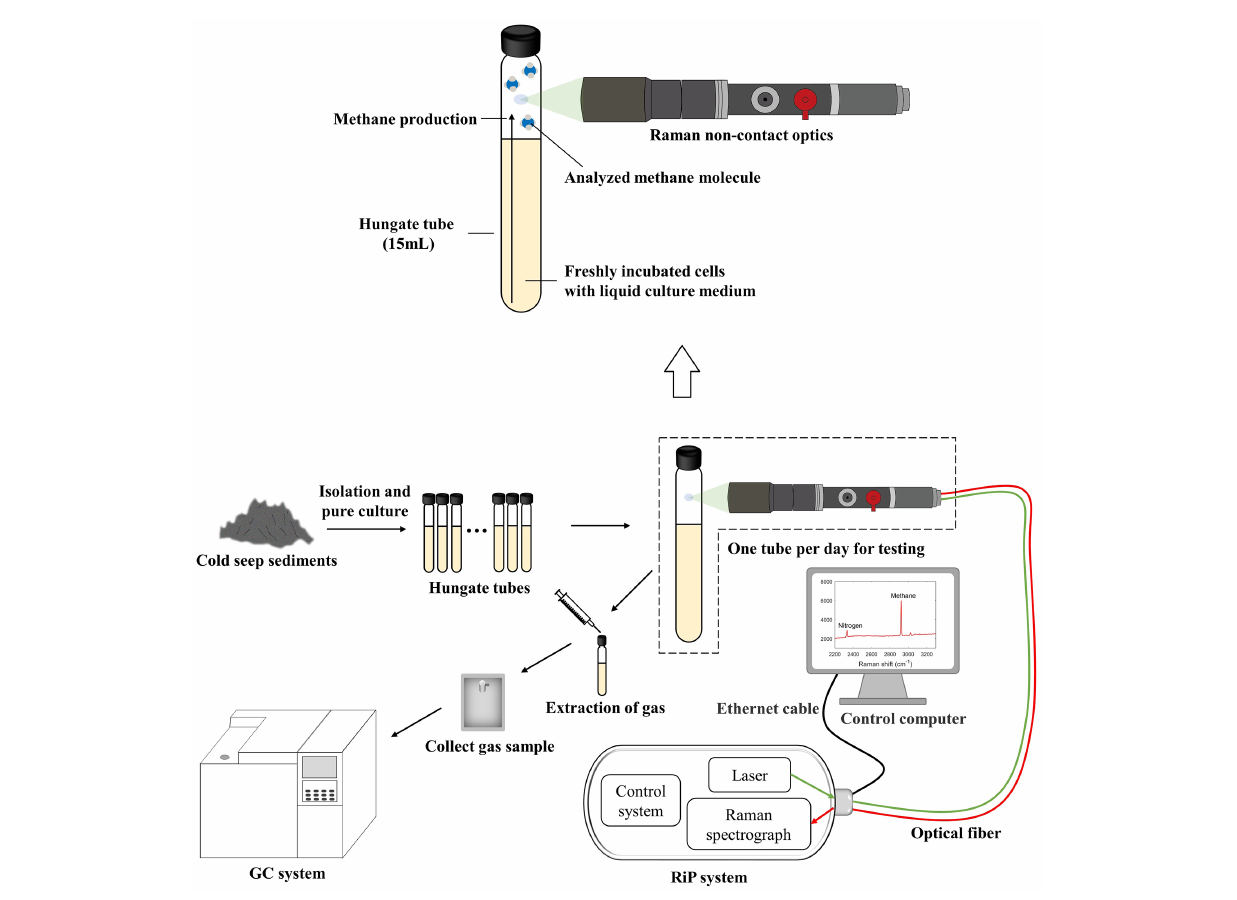
FIGURE 2 Schematic of the experimental system for the application of the calibration curve to the culture experiments. It shows real-time online in situ monitoring of methanogenesis using Raman spectroscopy. The partially enlarged insets illustrate the collection of gas Raman spectra. Raman spectra can easily be acquired by focusing the laser through Raman non-contact optics on the gas portion above the interior of the Hungate